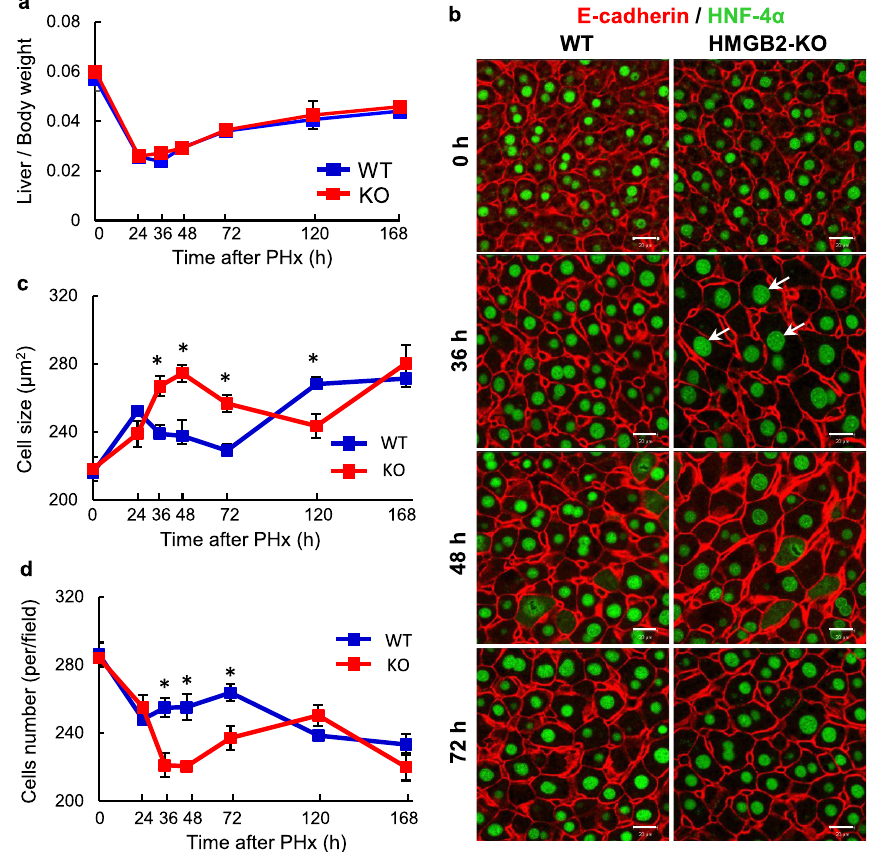
Figure 5. Compensatory hypertrophy during liver regeneration. ( a ) Ratio of mouse liver weight / body weight in WT and HMGB2-KO mouse livers during regeneration. ( b ) Double immunofluorescence for E-Cadherin (red) and HNF-4α (green) in WT and HMGB2-KO mouse livers after PHx. Arrows indicate hypertrophic hepatocytes. Scale bars 20 μm. Dynamic changes of hepatocyte size ( c ) and number ( d ) in WT and HMGB2-KO mouse livers during regeneration. Data represent the mean ± SEM from 5–6 mice per group. Asterisks indicate statistically significant differences (* p <